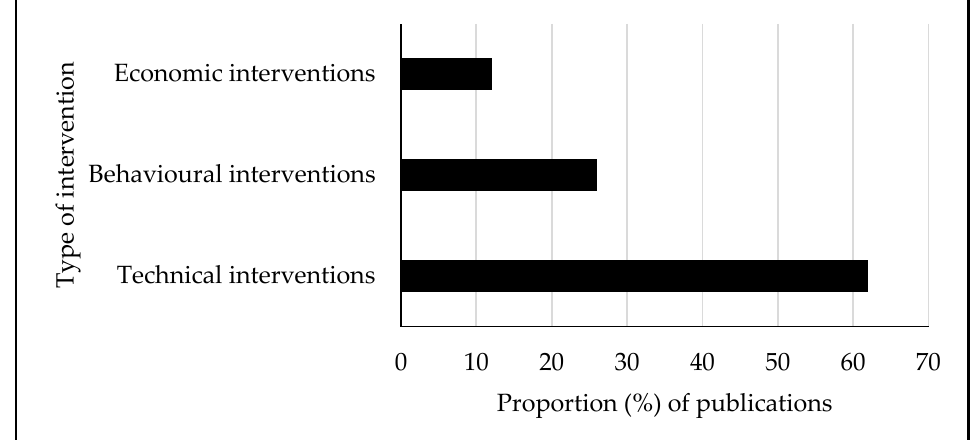
Figure 4. Types of electricity-saving interventions.